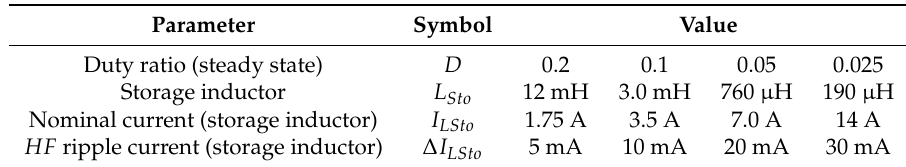
Table 3. Preliminary Data for Different Duty Ratio